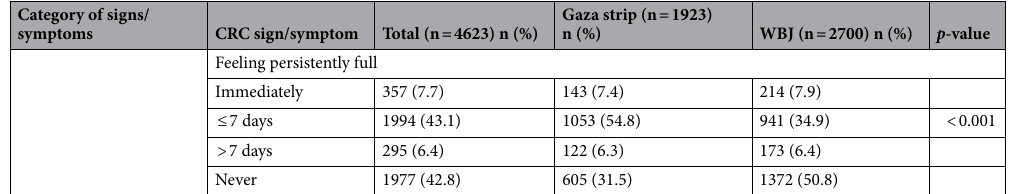
Table 2. Summary of the reported time to seek medical advice for a possible colorectal cancer symptom. n = number of participants, WBJ = West Bank and Jerusalem. All p -values are for Pearson’s Chi-square test.